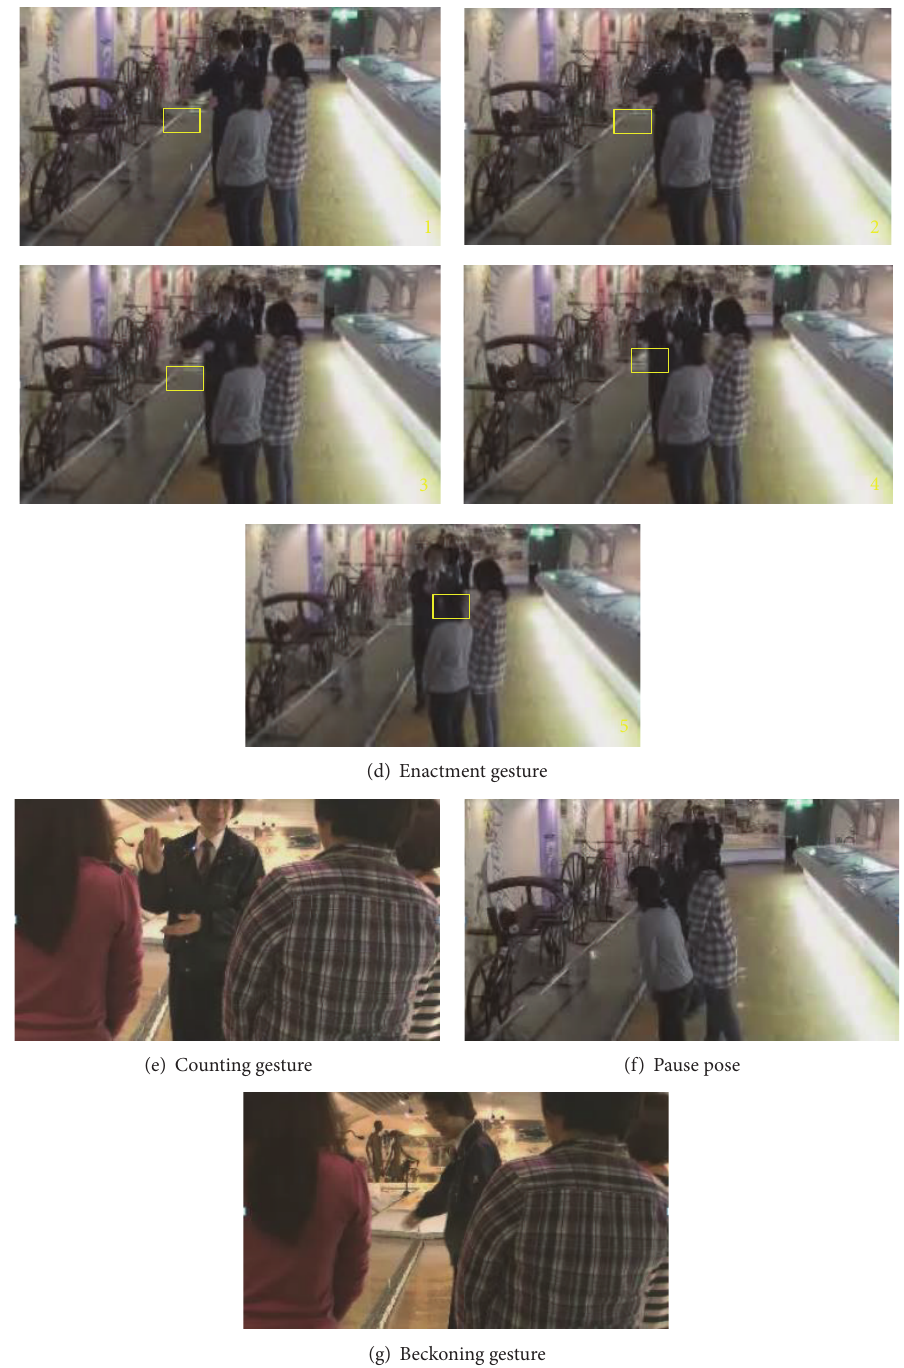
Figure 1: Gestures used by the museum curator to explain the exhibits to visitors during our field